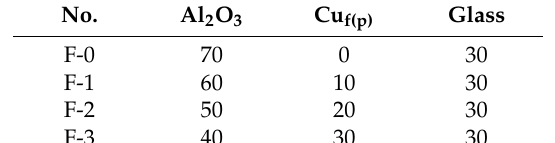
Table 2. Composition of Al 2 O 3 /glass/Cu composites (in volume).